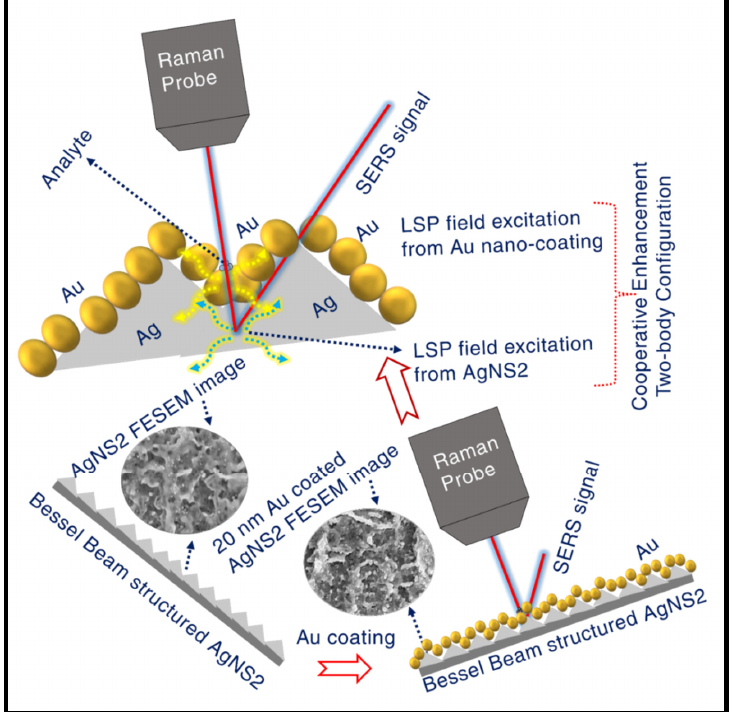
Figure 12. Schematic of Au coated AgNS2 explaining the mechanisms giving rise to cooperative enhancement from two-body system (AgNS2 + 20 nm Au). An evanescent electric field excitation is demonstrated in two-body system due to an appropriate match in penetration-depth condition.